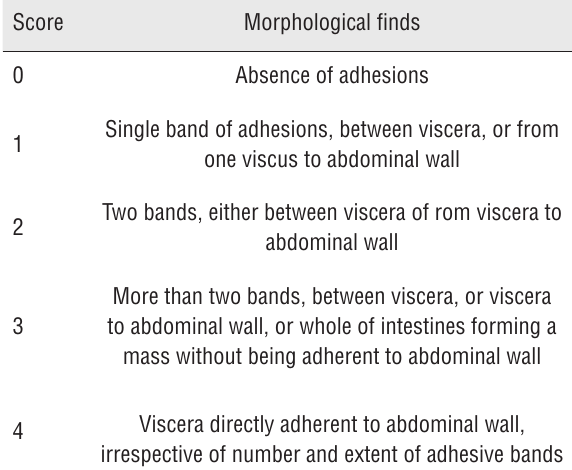
Table 1 - Nair score (Nair; Bath and Aurora,